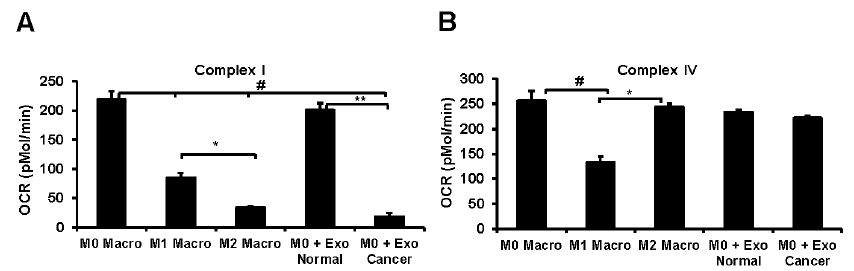
Figure 7. Mitochondrial respiratory chain complex activities of macrophages co-cultured with normal or tumor cell-derived exosomes. ( A ) Mitochondrial complex I activity determined in the presence of pyruvate / malate substrate after permeabilizing the plasma membrane using plasma membrane permeabilizer (PMP) in macrophages that are either polarized or co-cultured with exosomes. # p < 0.01 relative to M0 macrophages, * p < 0.05 relative to M1 macrophages and ** p < 0.001 relative to M0 macrophages treated with normal exosomes. ( B ) Mitochondrial complex IV activity determined using Ascorbate / TMPD substrate in the presence of rotenone. # p < 0.05 relative to M0 macrophages and * p < 0.01 relative to M1 macrophages.